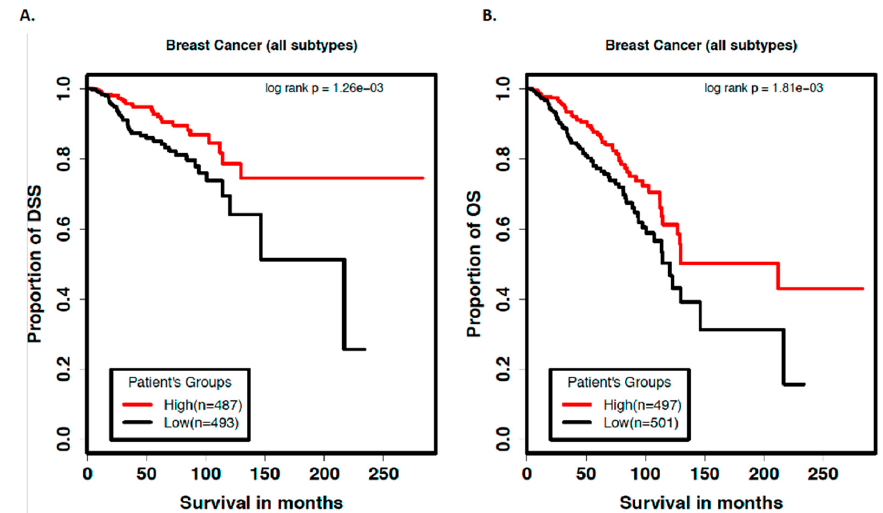
Figure 5. Low levels of let-7b-5p predict poor prognosis in breast cancer patients. Kaplan-Meier curves showing ( A ) disease-specific survival and ( B ) overall survival (in months) in breast cancer patients expressing high vs low levels of let-7b-5p.